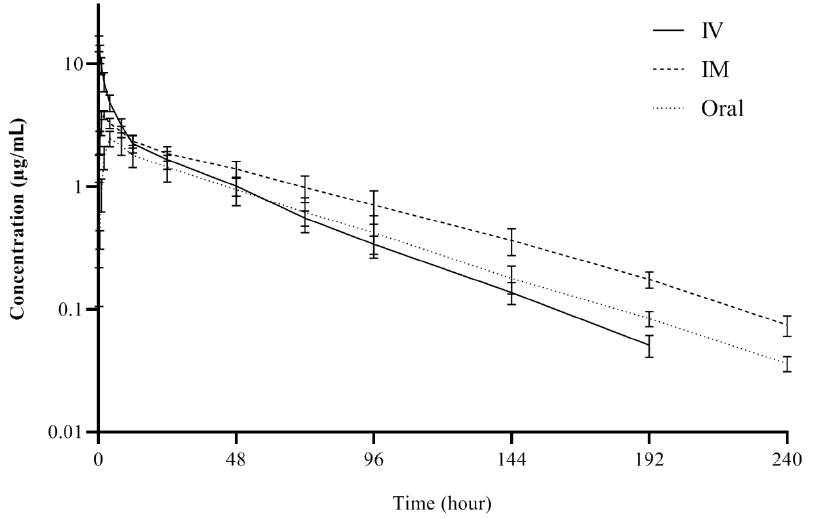
Figure 1. Semi-logarithmic plasma concentration-time curves of carprofen following intravenous (IV), intramuscular (IM) and oral administrations at a single dose of 2.5 mg/kg in rainbow trout ( Oncorhynchus mykiss ) broodstock at 10 ± 1.5 °C (mean ± SD, n = 6).